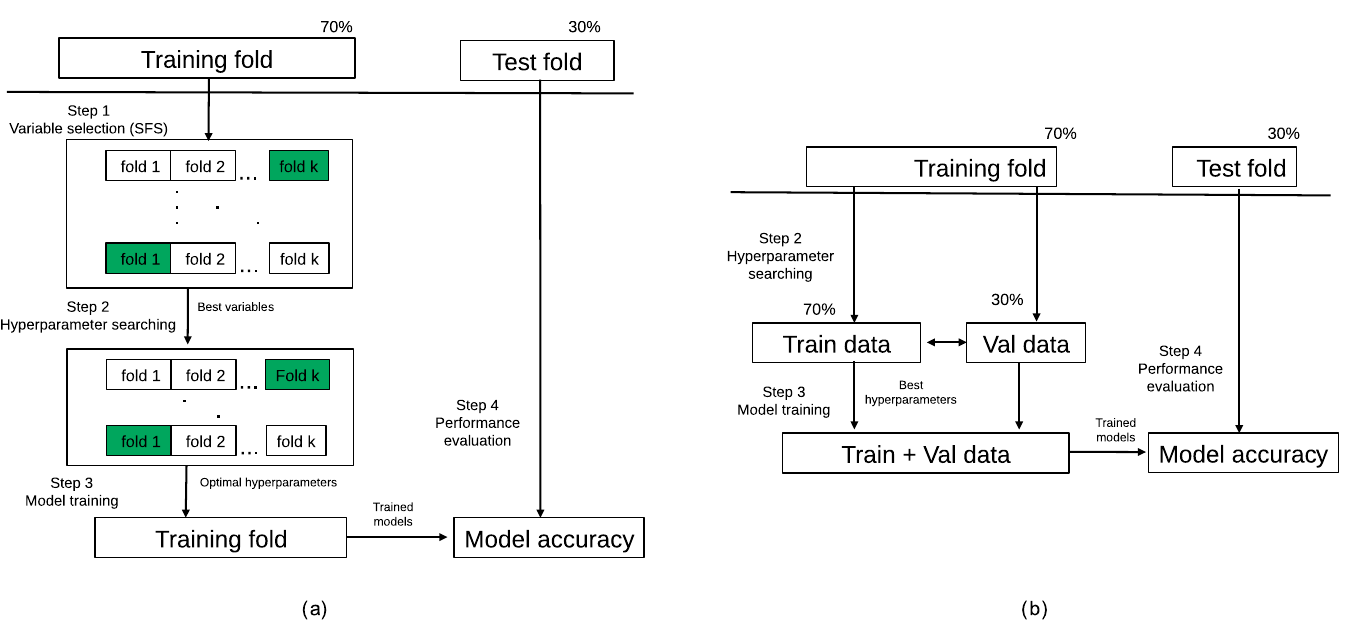
Fig 3. Data flows for the prediction model learning pipelines. Variable selection (step 1), search for hyperparameters (step 2), model training (step 3) and performance evaluation (step 4). Data flow (a) is used to compare machine learning classifiers and the effect of data collection time period analyses. Data flow (b) is used for the univariate model and model interpretability